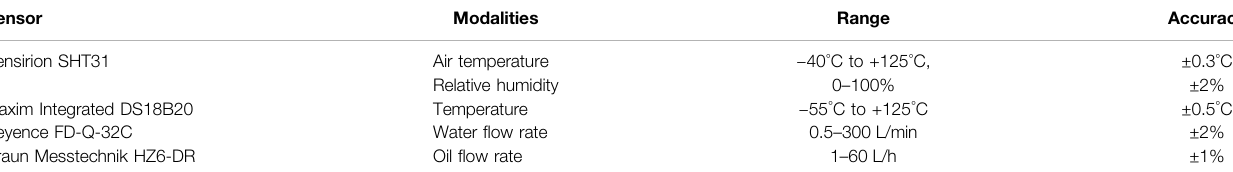
TABLE 3 | Overview of sensors deployed in the case study with the corresponding accuracy ranges from their documentation. Sensor Modalities Range Accuracy Sensirion SHT31 Air temperature − 40 ° C to +125 ° C, ± 0.3 ° C Relative humidity 0 – 100% ± 2% Temperature Keyence